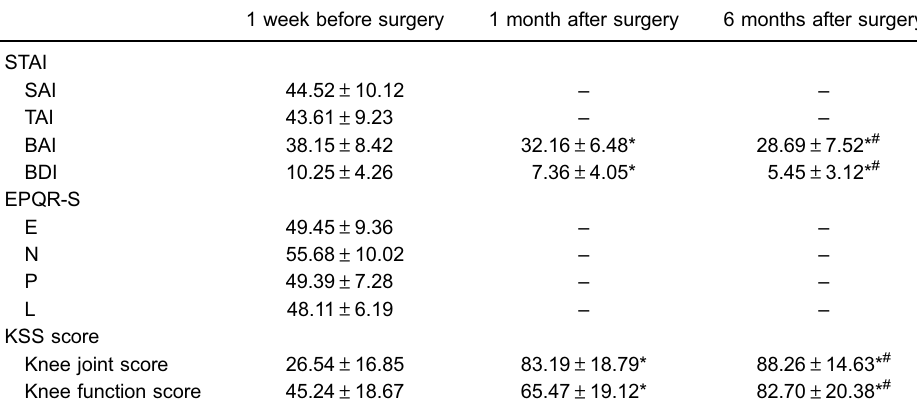
Table 1. Scores of various psychological scales before and after